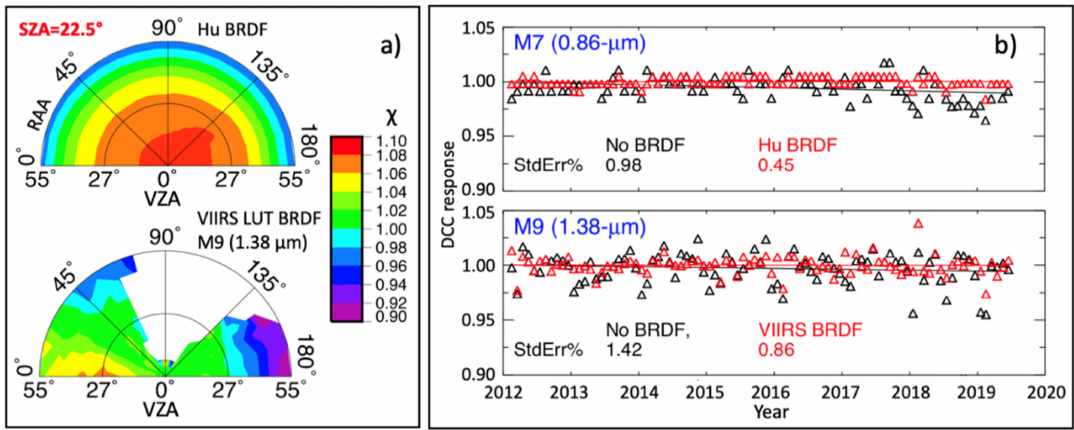
Figure 1. ( a ) Comparison of Hu BRDF (top) versus LUT BRDF (bottom) derived using SNPP-VIIRS M9 (1.38 µ m) for the 5 ◦ SZA bin centered at 22.5 ◦ . The radial coordinate represents VZA (range 0 ◦ to 55 ◦ ) with a 5 ◦ bin size, whereas the angular coordinate represents RAA with a 10 ◦ bin size. The unsampled bins are left out as white spaces. ( b ) Comparison of normalized DCC response time series for SNPP-VIIRS M7 (0.86 µ m) and M9 bands with (red triangles) and without (black triangles) the BRDF